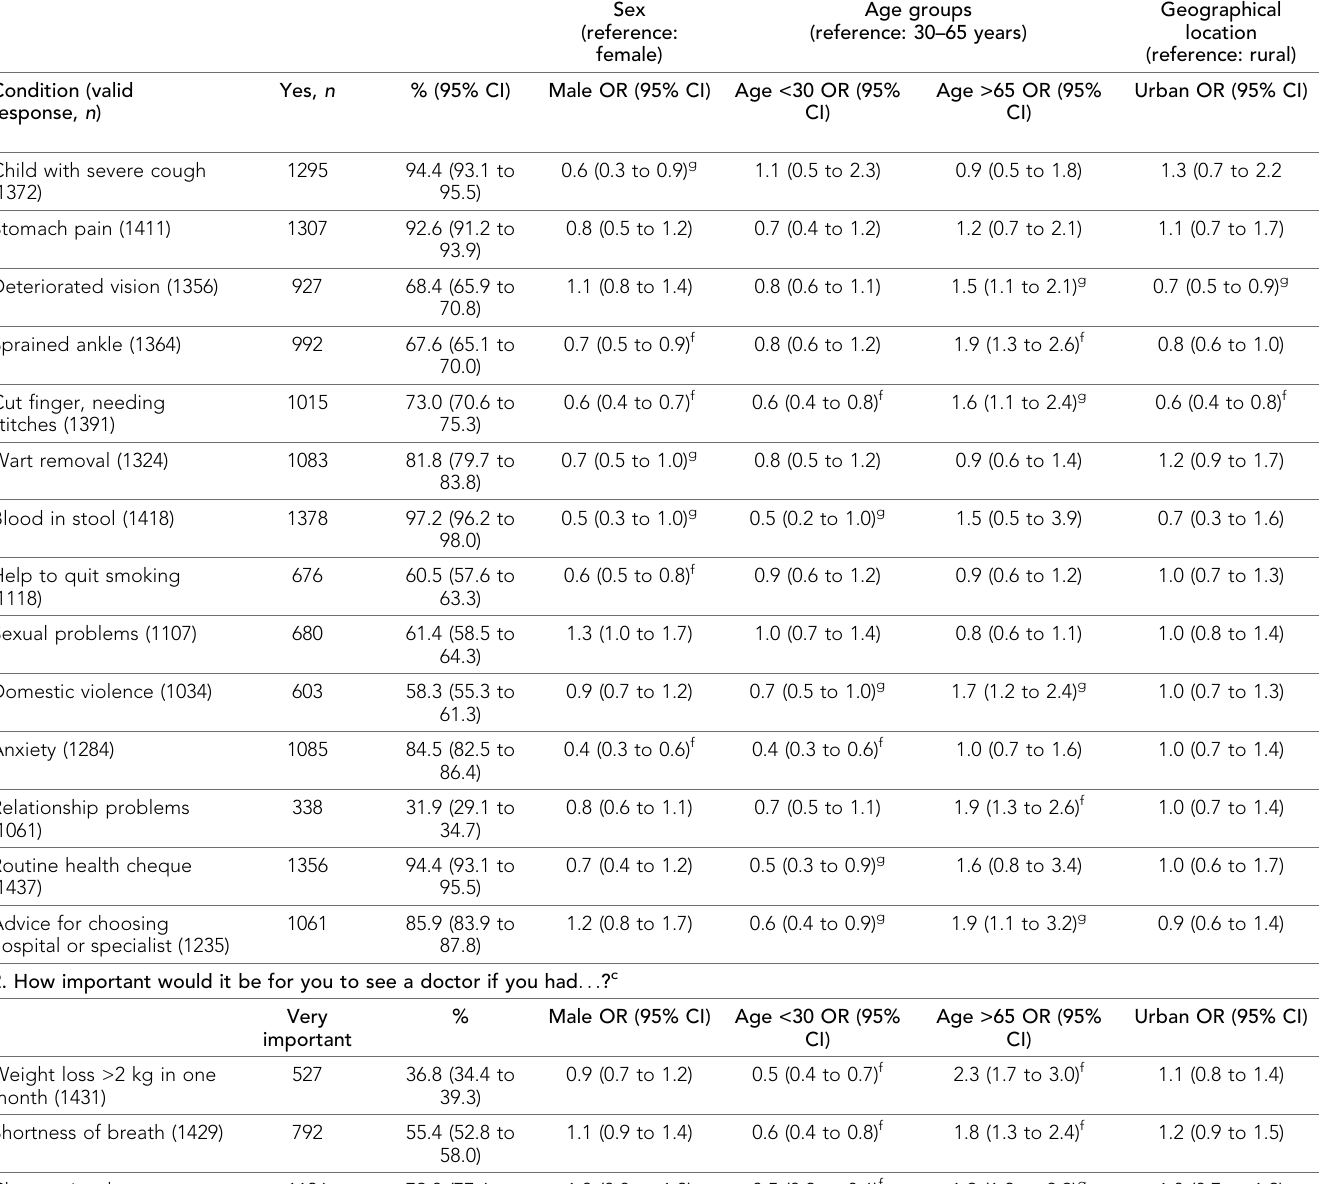
Table 3. Patients’ views on anticipated healthcare-seeking behaviour. Responses from patients ( N = 1529, n = valid responses) participating in the Norwegian part of the QUALICOPC study, 2012–2013. Results given as valid percentages and ORs with 95% CIs by sex, age, and location 1. Would most patients see their GP for the following conditions?